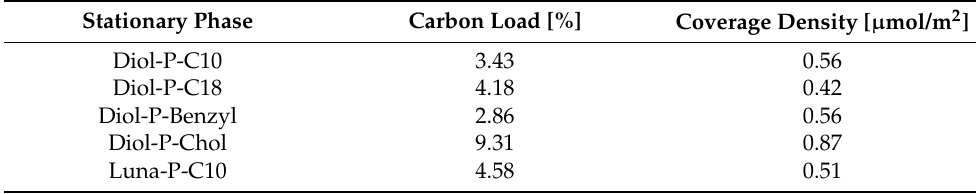
Table 3. Characteristic of stationary phases used in the